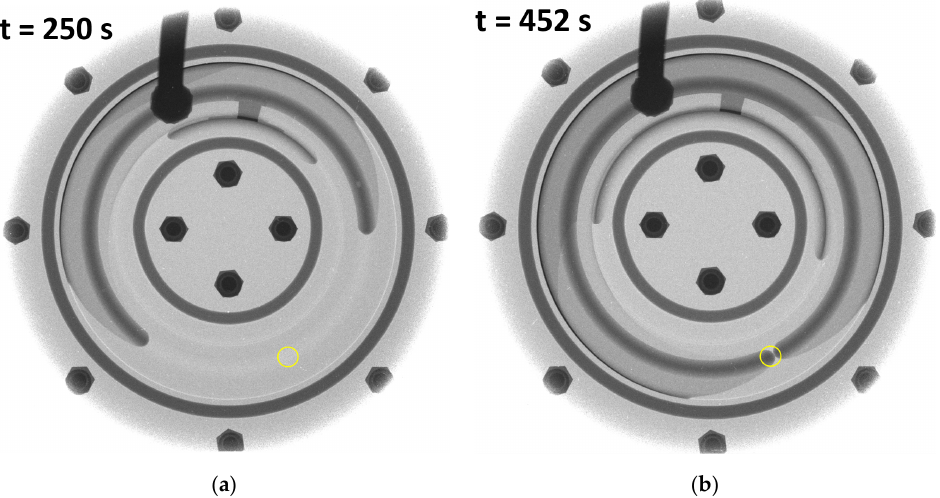
Figure 14. NR images of the fi lling process for the “Top” case. ( a ) NR image at half time of the fi lling process; ( b ) NR image at touching time of the fi lling process.